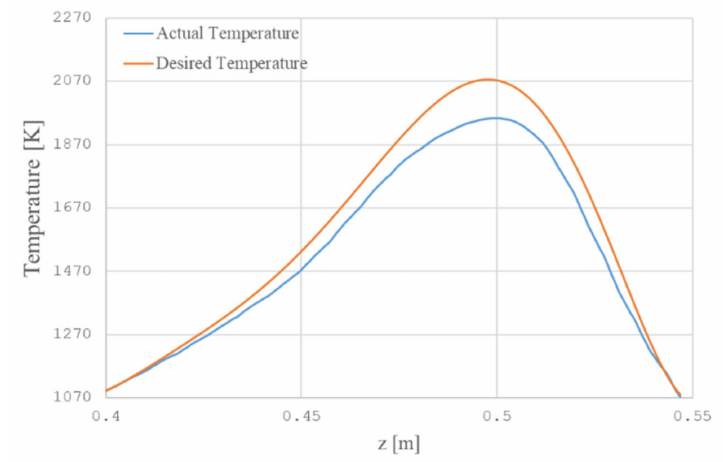
Figure 8. Actual and desired temperature at time t = 225 [s].